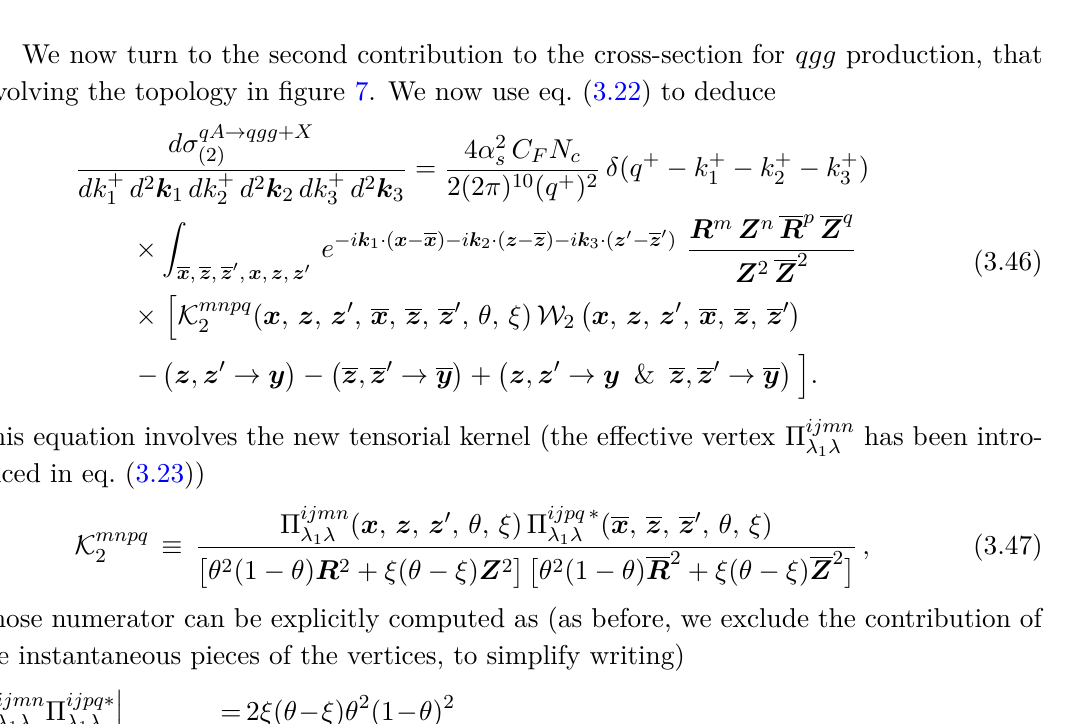
Figure 10 . A graph contributing to the cross-section in (3.46); the associated S -matrix is shown in eq.